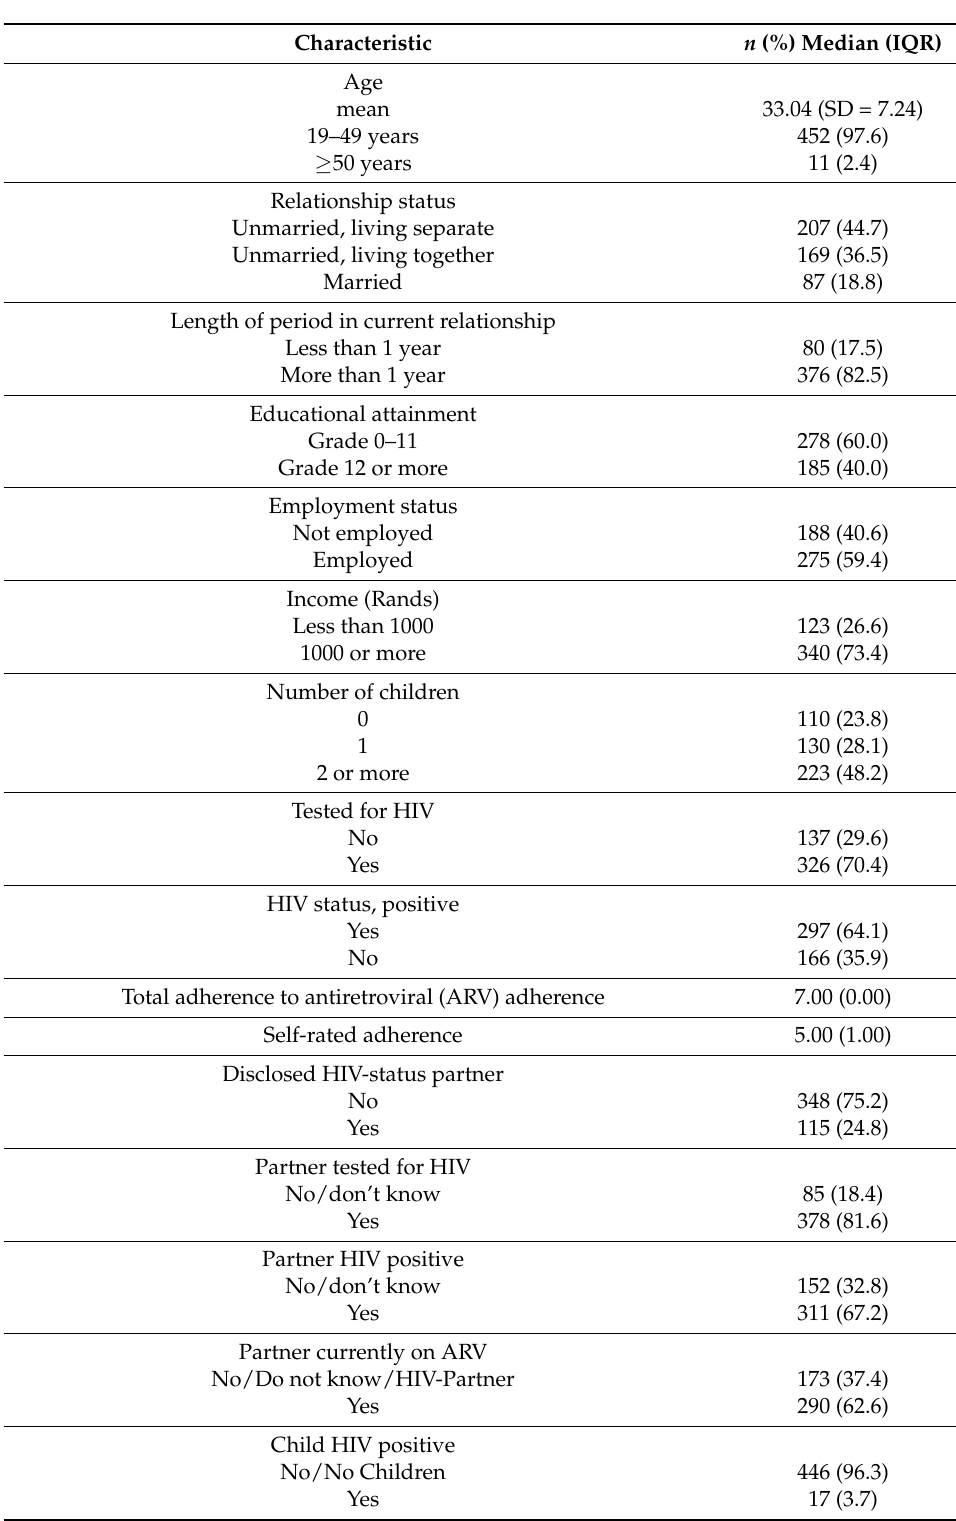
Table 1. Socio-demographic, partner characteristics and behavioral characteristics of the male partners ( N =